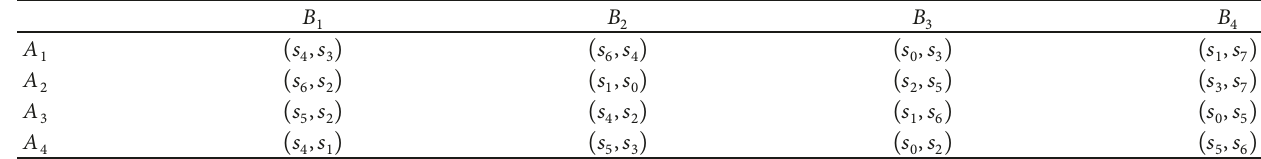
Table 8: The linguistic Pythagorean fuzzy preference information matrix 𝐿 provided by the decision-maker 𝑀 .